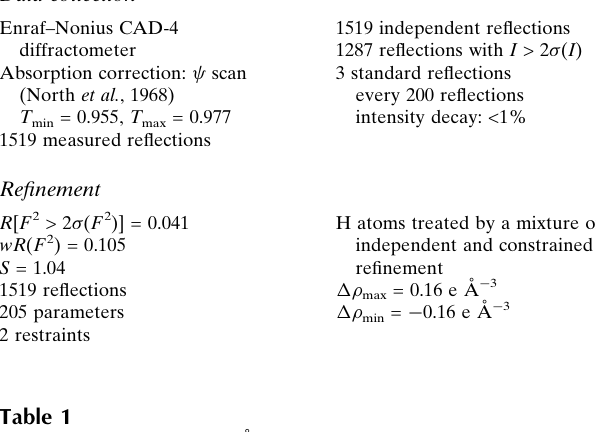
Hydrogen-bond geometry (A˚ , (cid:4)